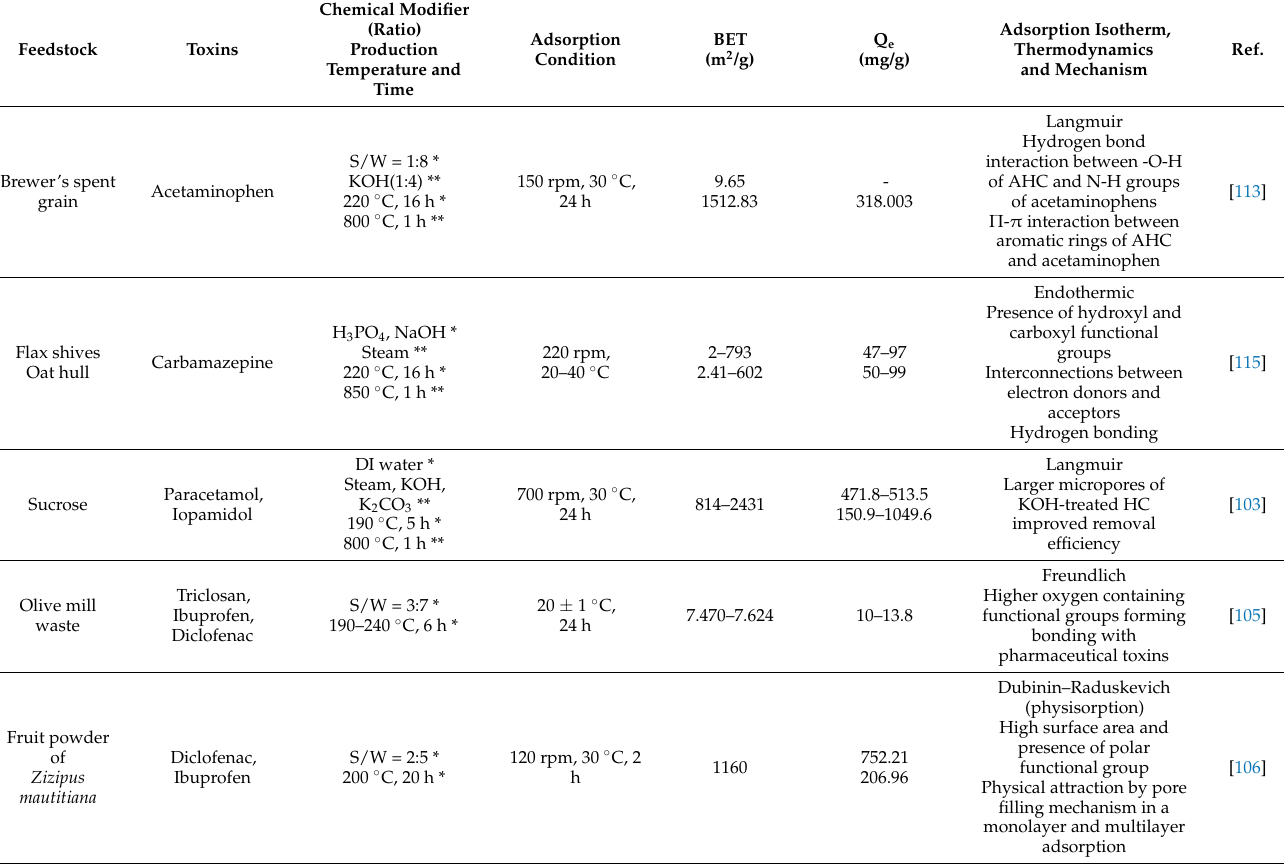
Table 4. Toxin removal by